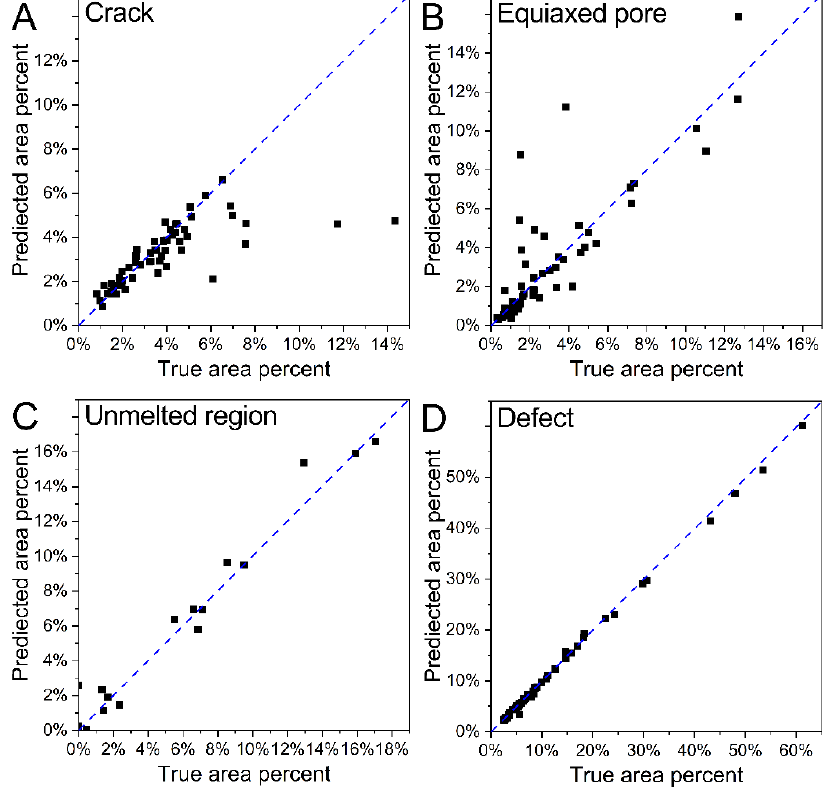
Figure 10. True and predicted area percentages of different microstructures in the test images: ( A ) crack, ( B ) equiaxed pore, ( C ) unmelted region, and ( D ) defect. The large difference between true and predicted values for crack and equiaxed pore may have been caused by the small image size (256 pixels × 256 pixels, 12.5 µ m × 12.5 µ m),